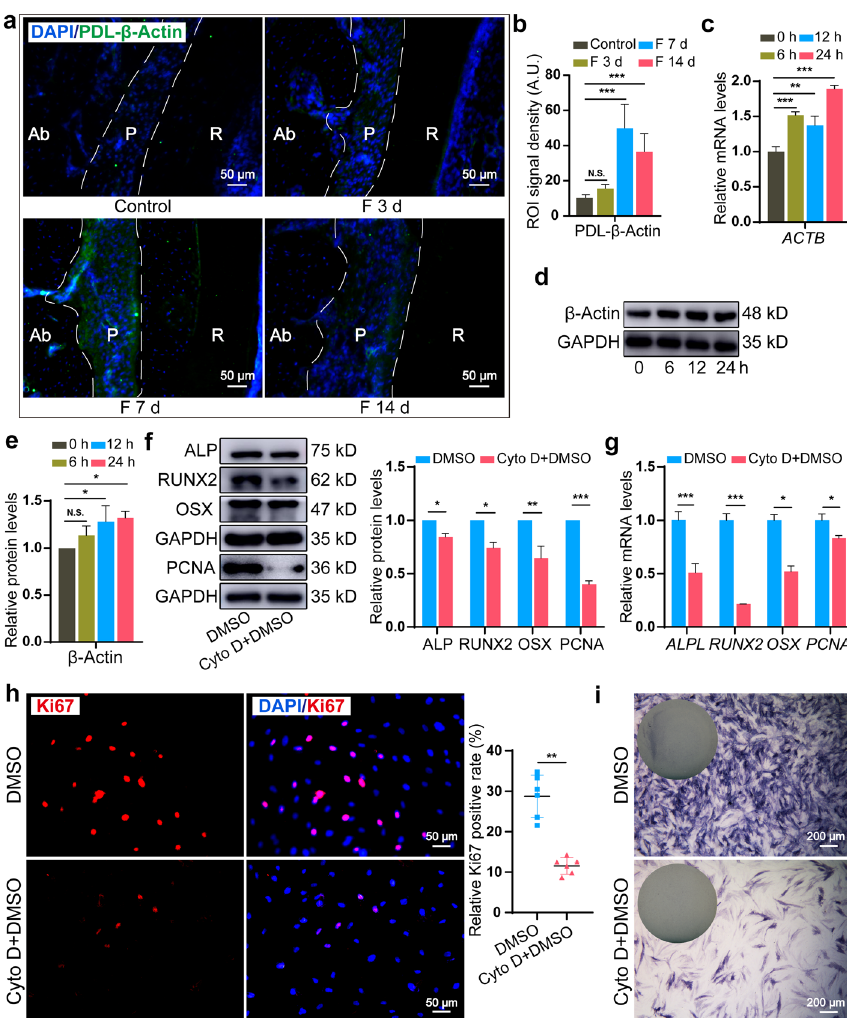
Fig. 4 Disrupted F-actin dynamics suppressed osteogenic commitment in force-induced PDLSCs. a , b Immunofluorescence and semi-quantitative analysis of β-Actin expression in the periodontium during mechanical force application. N 5. Ab, alveolar bone; P, periodontal tissue; R, root. Dotted lines mark the = boundary of the PDL. Scale bar, 50 μm. c The mRNA expression of ACTB in PDLSCs during CSS loading. d , e The protein expression of β-Actin in PDLSCs during CSS loading. f The protein expression of ALP, RUNX2, OSX, and PCNA in the DMSO and Cyto D DMSO groups after stretching for 24 h. g The mRNA + expression of ALPL , RUNX2 , OSX , and PCNA in the DMSO and Cyto D DMSO groups after stretching for + 24 h. h Immunofluorescence and semi-quantitative analysis of Ki67 + cells in the DMSO and Cyto D DMSO + groups after stretching for 24 h. Scale bar, 50 μm. i ALP staining in the DMSO and Cyto D DMSO groups + after stretching for 24 h. Scale bar, 200 μm. * P < 0.05, ** P < 0.01, *** P < 0.001. N.S., no significance. Results are presented as mean SD of triplicated ±